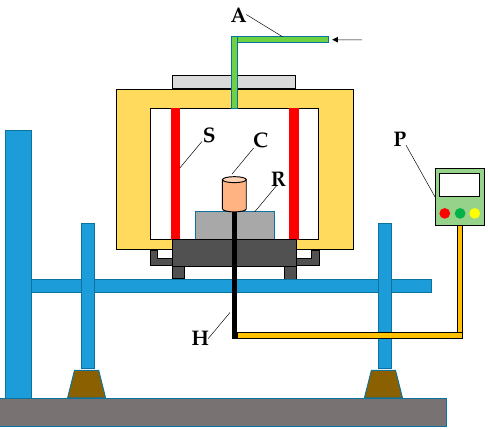
Figure 5. Schematic of the redox reaction furnace (A — Air intake, S — Silicon – Molybdenum Bar, C —